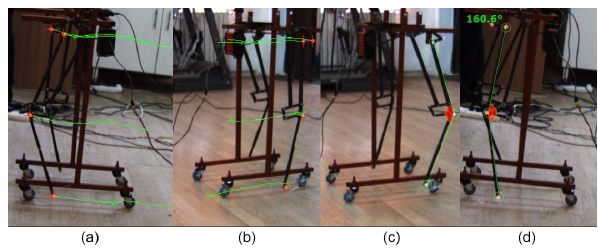
Figure 24. Marker tracking for exoskeleton kinematics: (a, b) com- putation of trajectories; (c, d) computation of knee joints angular